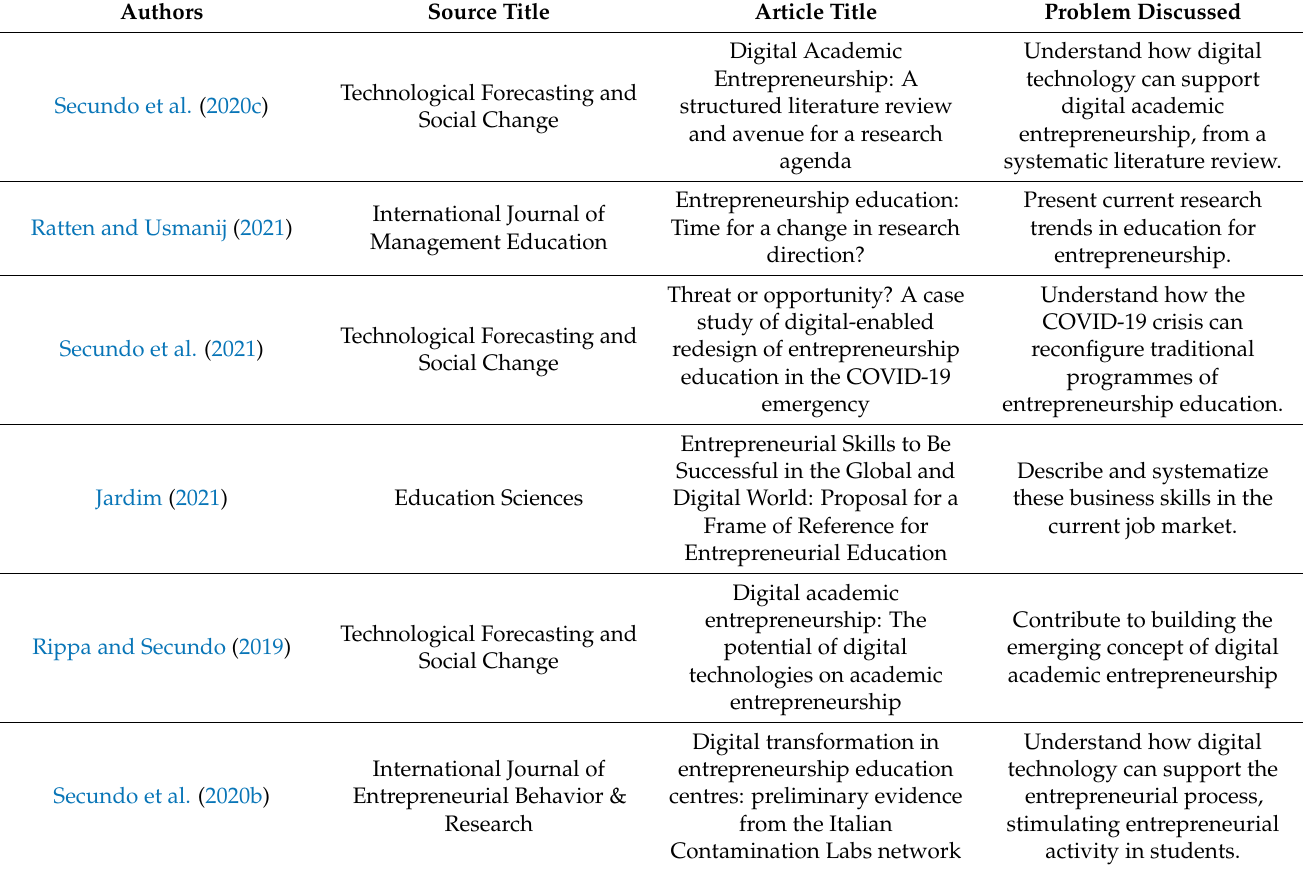
Table 1. Problems addressed by each author researching the topic. Source: Research